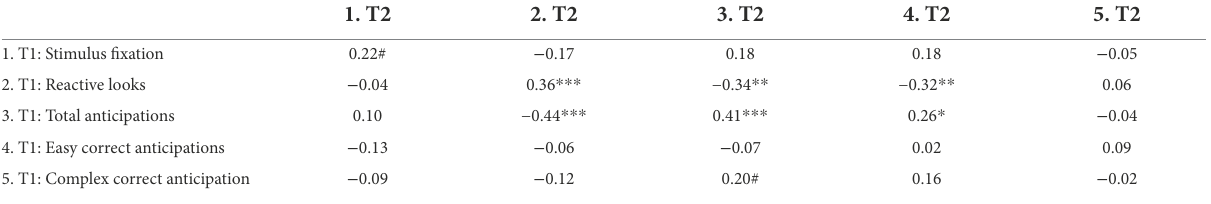
TABLE 10 Two-tailed partial correlation coefficients, controlling by age, for VLS scores in the first and follow-up